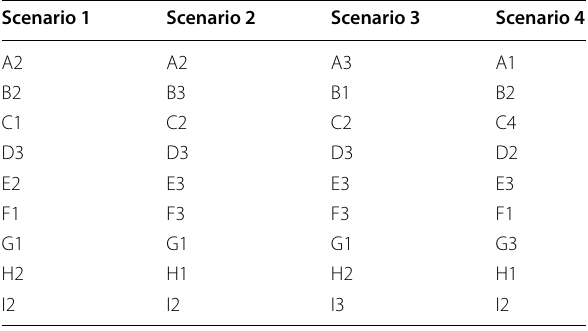
Table 5 More consistent scenarios for developing Indonesian road infrastructure